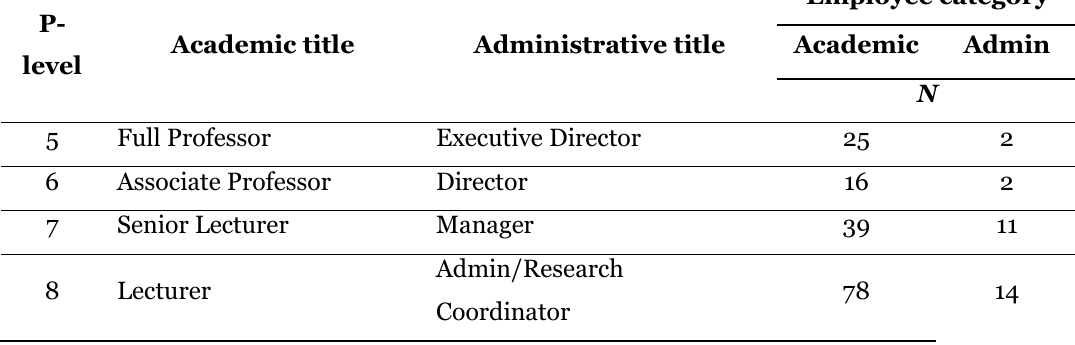
Sample Structure by Peromnes Job Level and Employment